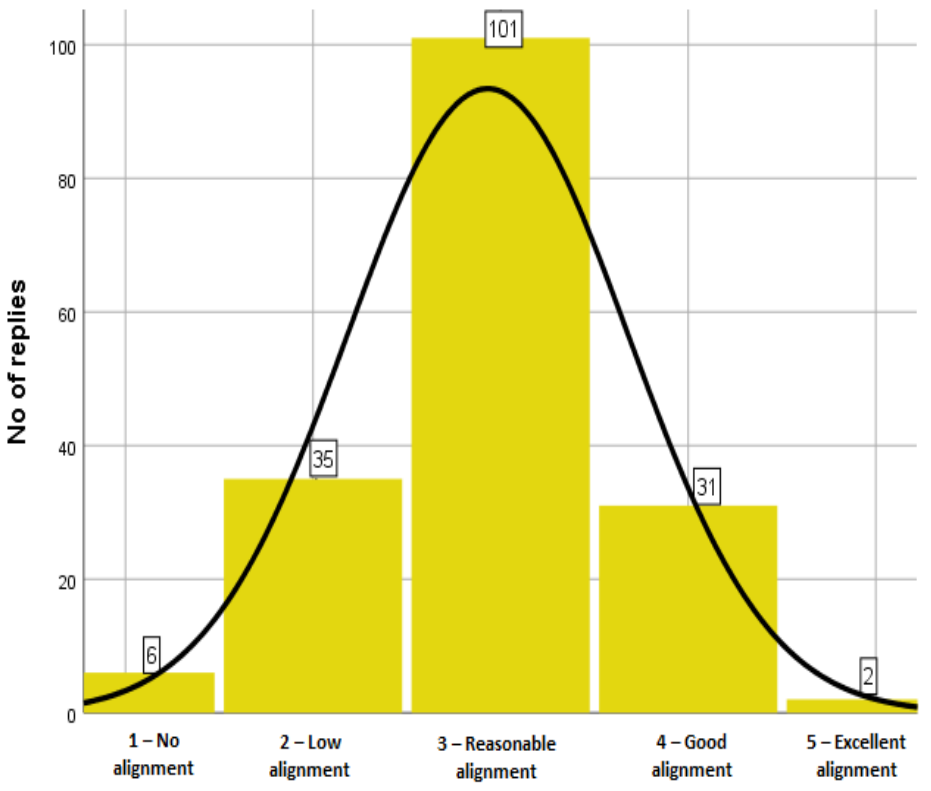
Figure 4. Evaluation of the alignment between the DSFW and the spatial planning policies ( x = 2.93; SD = ±0.75; N = 175).